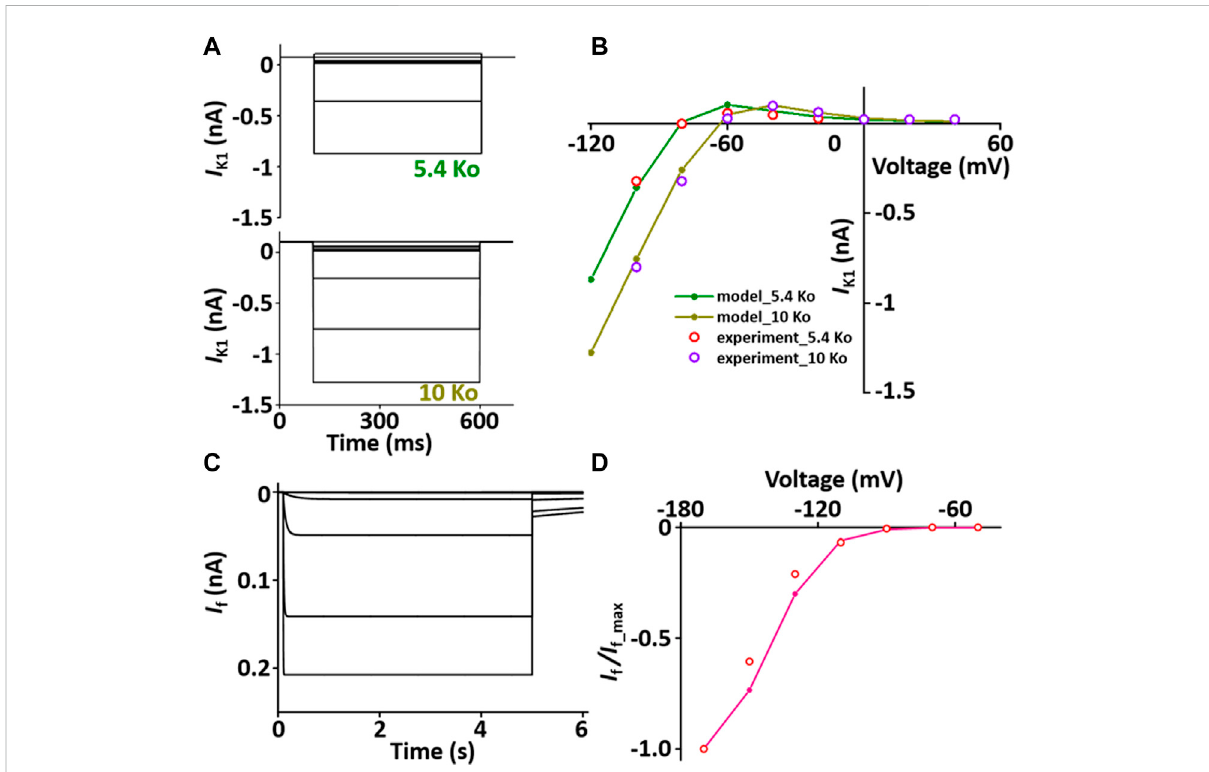
FIGURE 4 Veri fi cation of I K1 and I f implementation (Kim, 2018). (A) Simulated current traces of the hyperpolarization-activated channel at extracellular K + ionconcentrationsof5.4 mM(5.4Ko)and10 mM(10Ko). (B) Normalizedsimulated I-V relationshipfor I K1 (oliveanddarkyellowlines).Thissimulated result is in close agreement with the representative experimental results (experiment_5.4 Ko, experiment_10 Ko) which were digitized from Pandit etal.(2001)). (C) Simulatedcurrenttracesofthehyperpolarization-activated channel. (D) Normalized simulated I-V relationshipfor I f (pinkline). This simulated result is in close agreement with the representative experimental result (o, Fares et al. (Fares et al., 1998)).